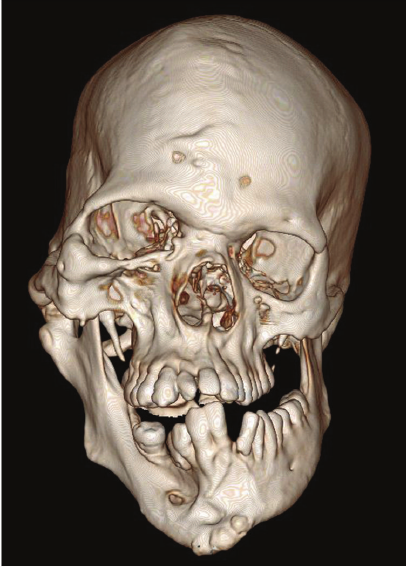
Figure 8: 3D volume rendered CTscan showing enlarged mandible, maxilla, and zygoma, with enlarged right mental foramen and teeth of the right side.